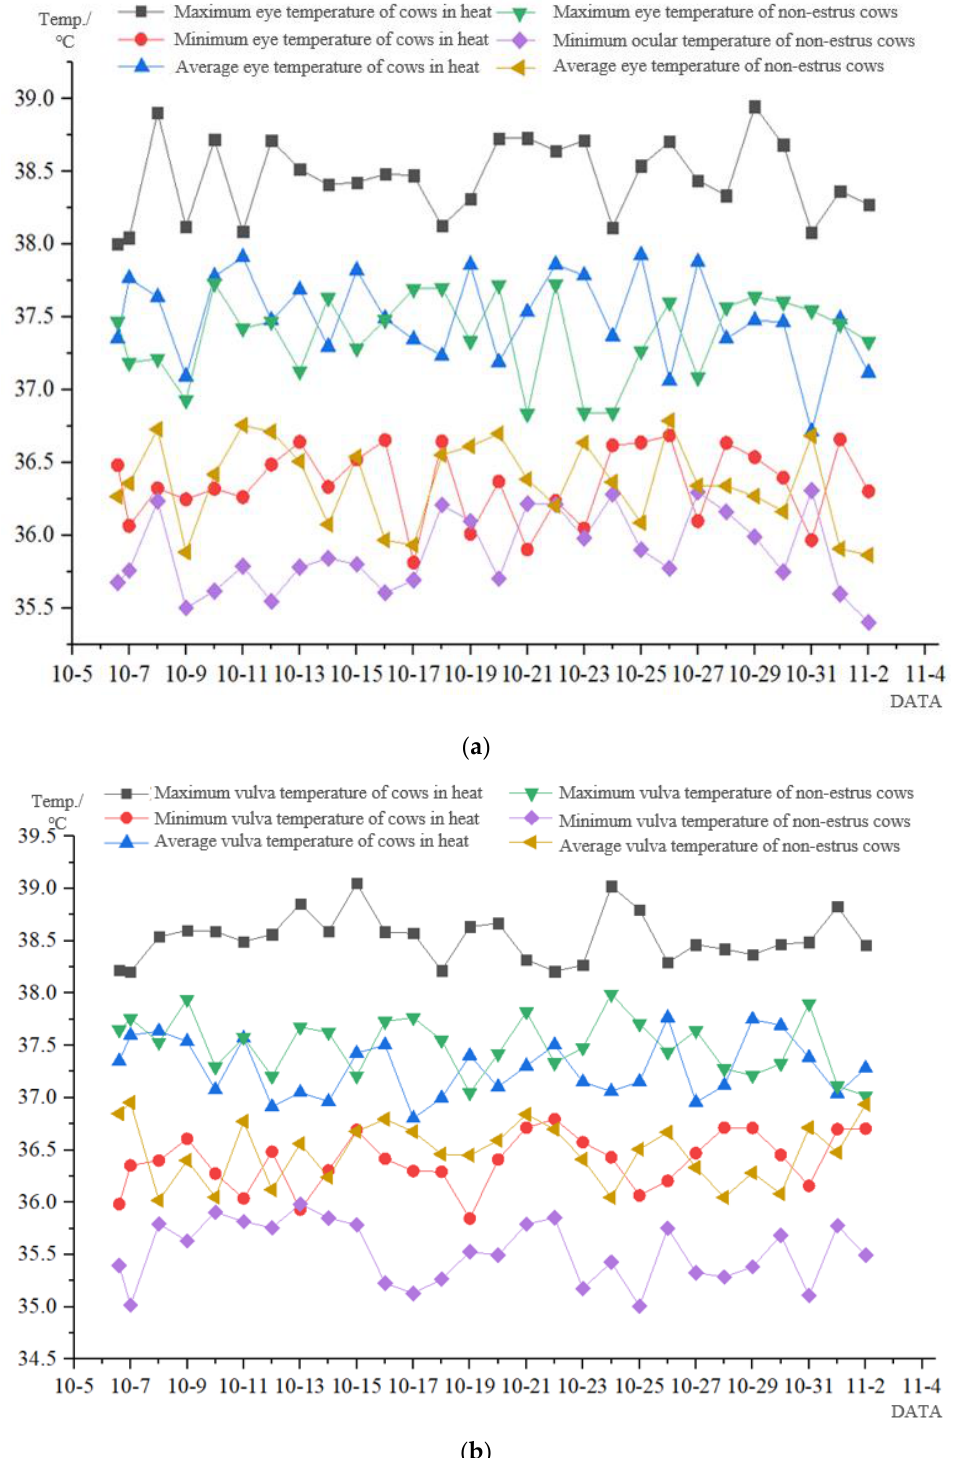
Figure 10. Maximum, minimum and average ocular and vulvar temperatures of anestrous and estrous cows during an estrous cycle. ( a ) Graph of the variation in eye temperature in cows, and ( b ) graph of the variation in vulva temperature in cows.